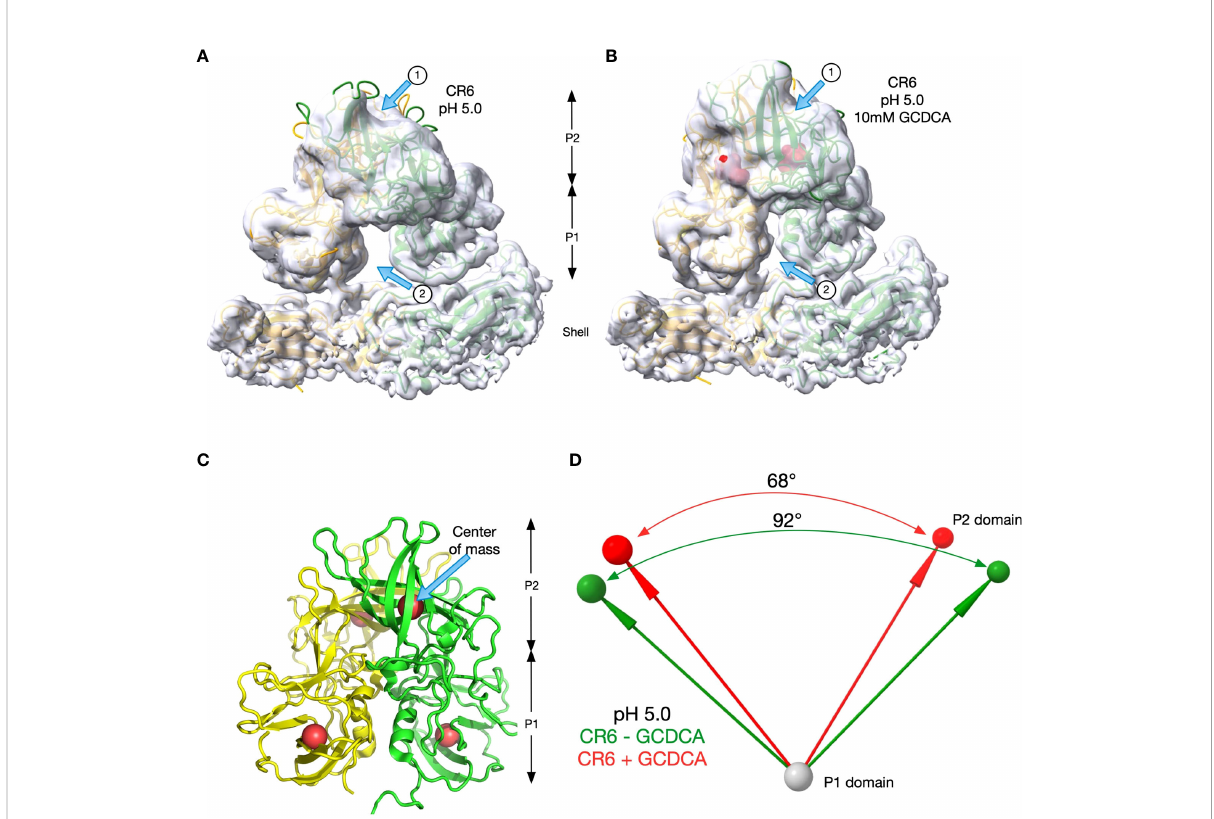
FIGURE 7 CR6 differs from the other strains at low pH. (A, B) The rigid body fi tting results of the structure of MNV1 into the unsharpened cryo-EM maps of CR6 at pH 5 in the absence (A) and presence (B) of 10mM GCDCA. Unlike the other strains, the angles between the P domains changes at low pH in the presence and absence of GCDCA. (C) To measure these angles, the center of masses of the P1 and P2 domains for both subunits were calculated (red spheres). These positions were then used to calculate the vectors between the subunits as summarized in panel d. (D) The vectors and angles between the P domains in the CR6 structure in the presence (red) and absence (green) of 10mM GCDCA are